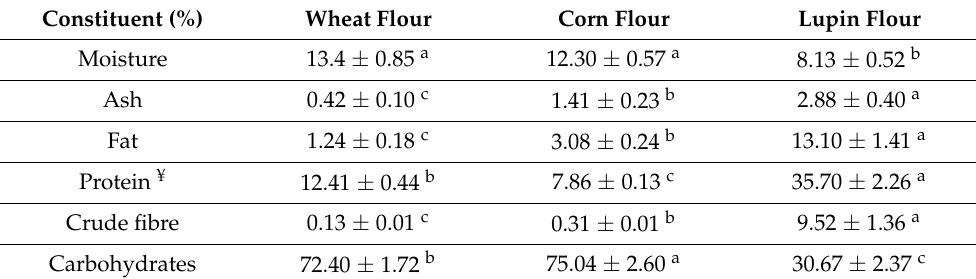
Table 1. Proximate composition of the various flours.